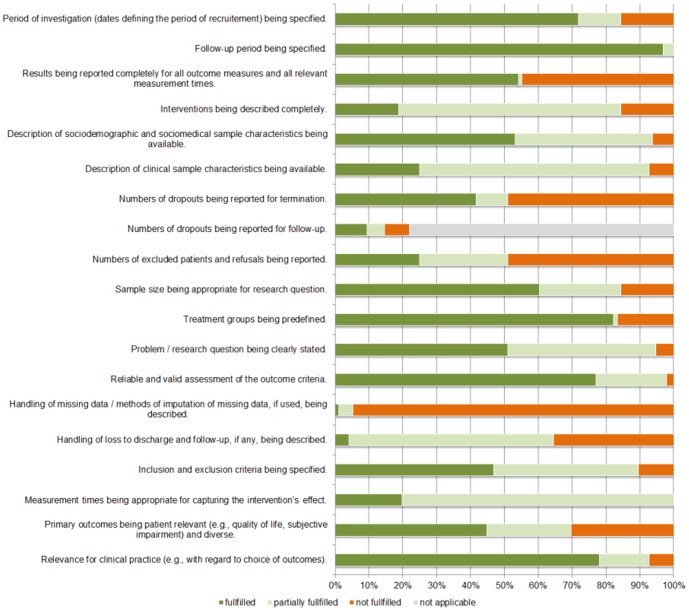
Distribution of quality criteria (k = 96 samples).